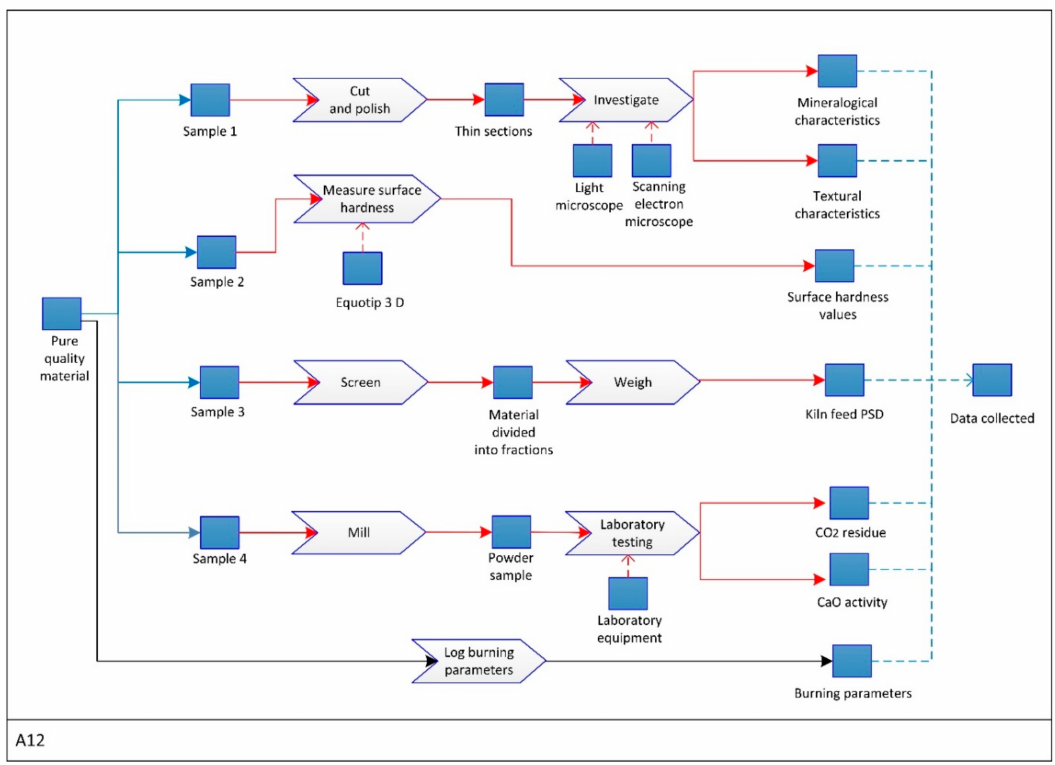
Figure 8. The Test and analyze function decomposed into details. Note the use of the “generalization” type of relation (dashed blue lines). PSD—particle size